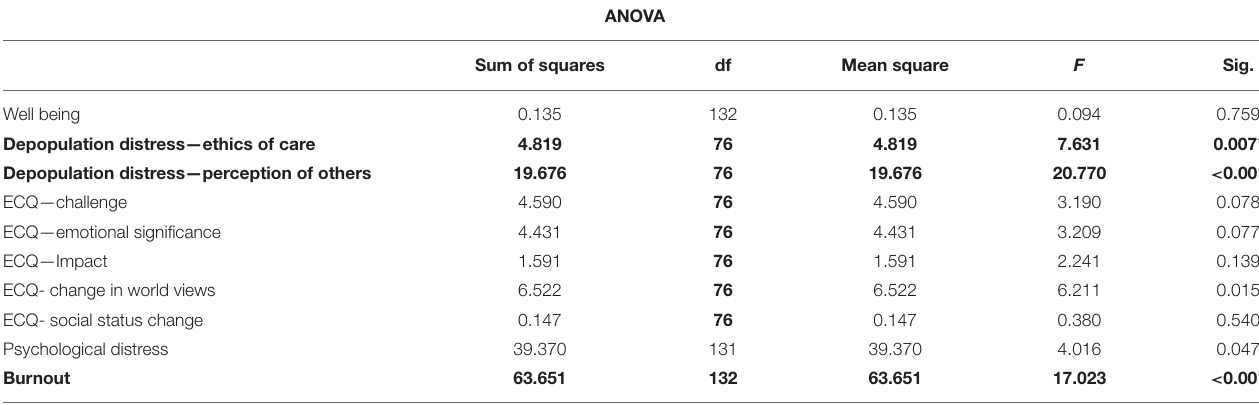
TABLE 13 | ANOVA table assessing the relationship between depopulation method (VSD + or other methods) and well being, psychological distress, burnout, depopulation distress (ethics of care, perception of others), and ECQ factors. ANOVA Sum of squares df Mean square F Sig. Well being 0.135 132 0.135